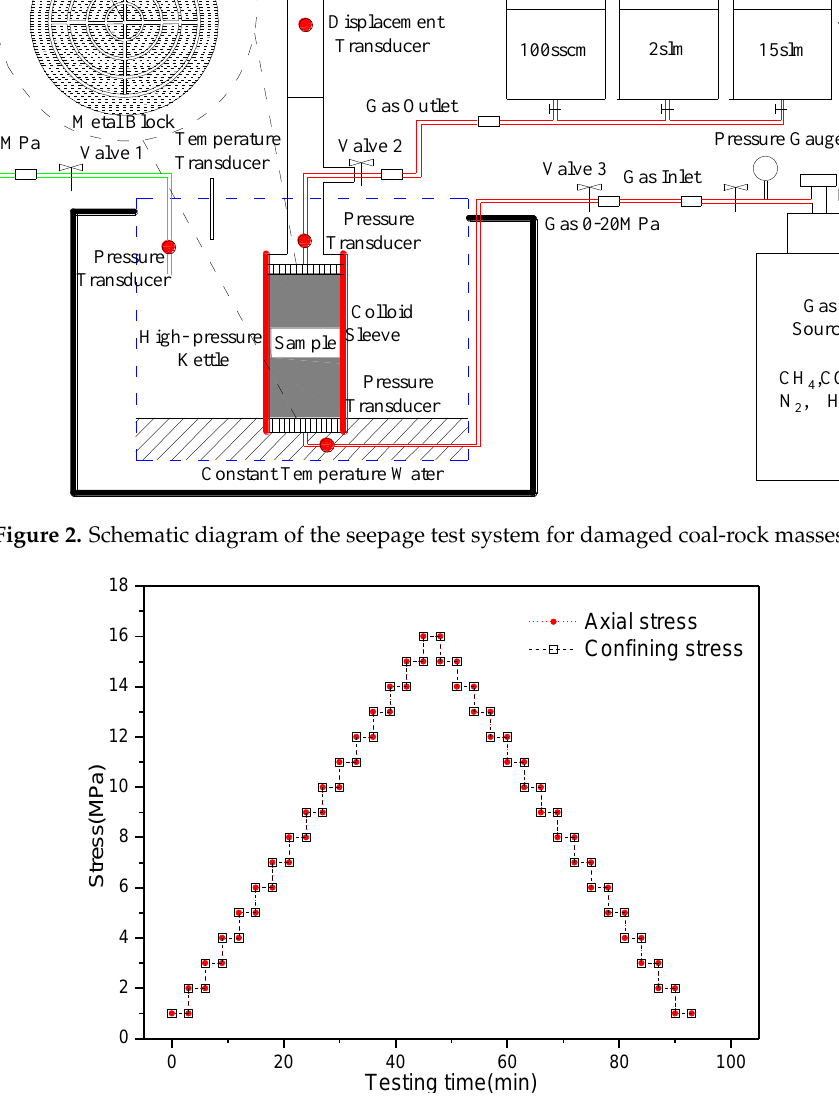
Figure 3. Stress path during each loading and unloading cycle.